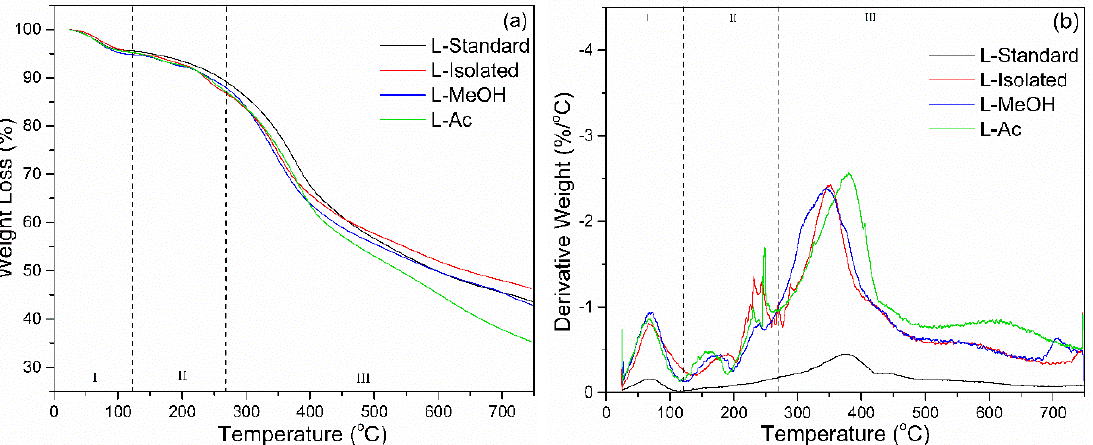
Figure 5. Thermal behavior of lignin before and after fractionation: ( a ) TGA, ( b ) DTG.